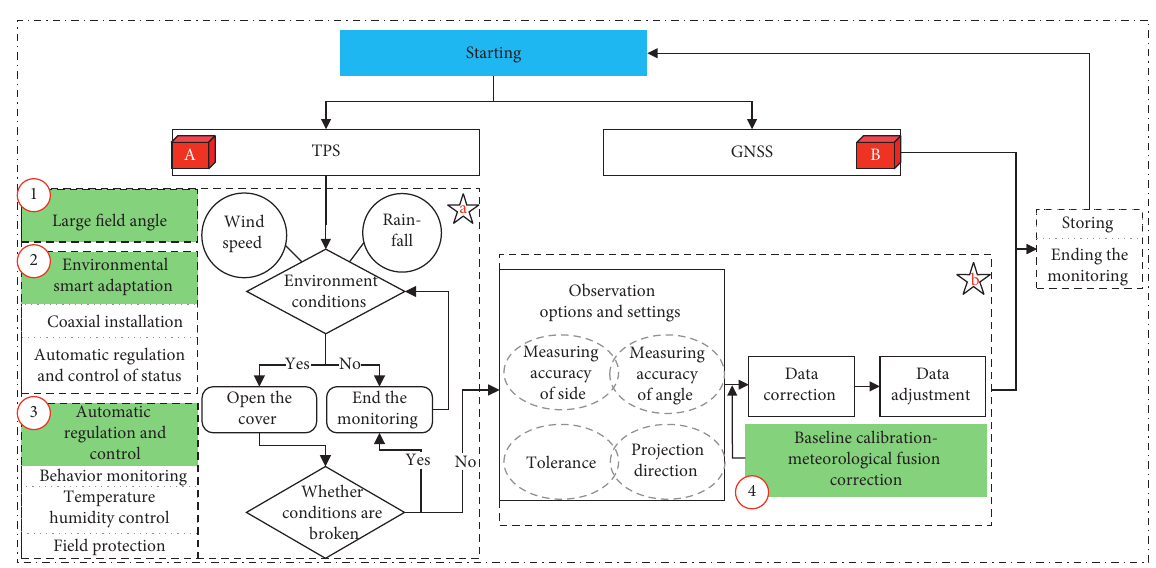
Figure 2: Smart measurement process of